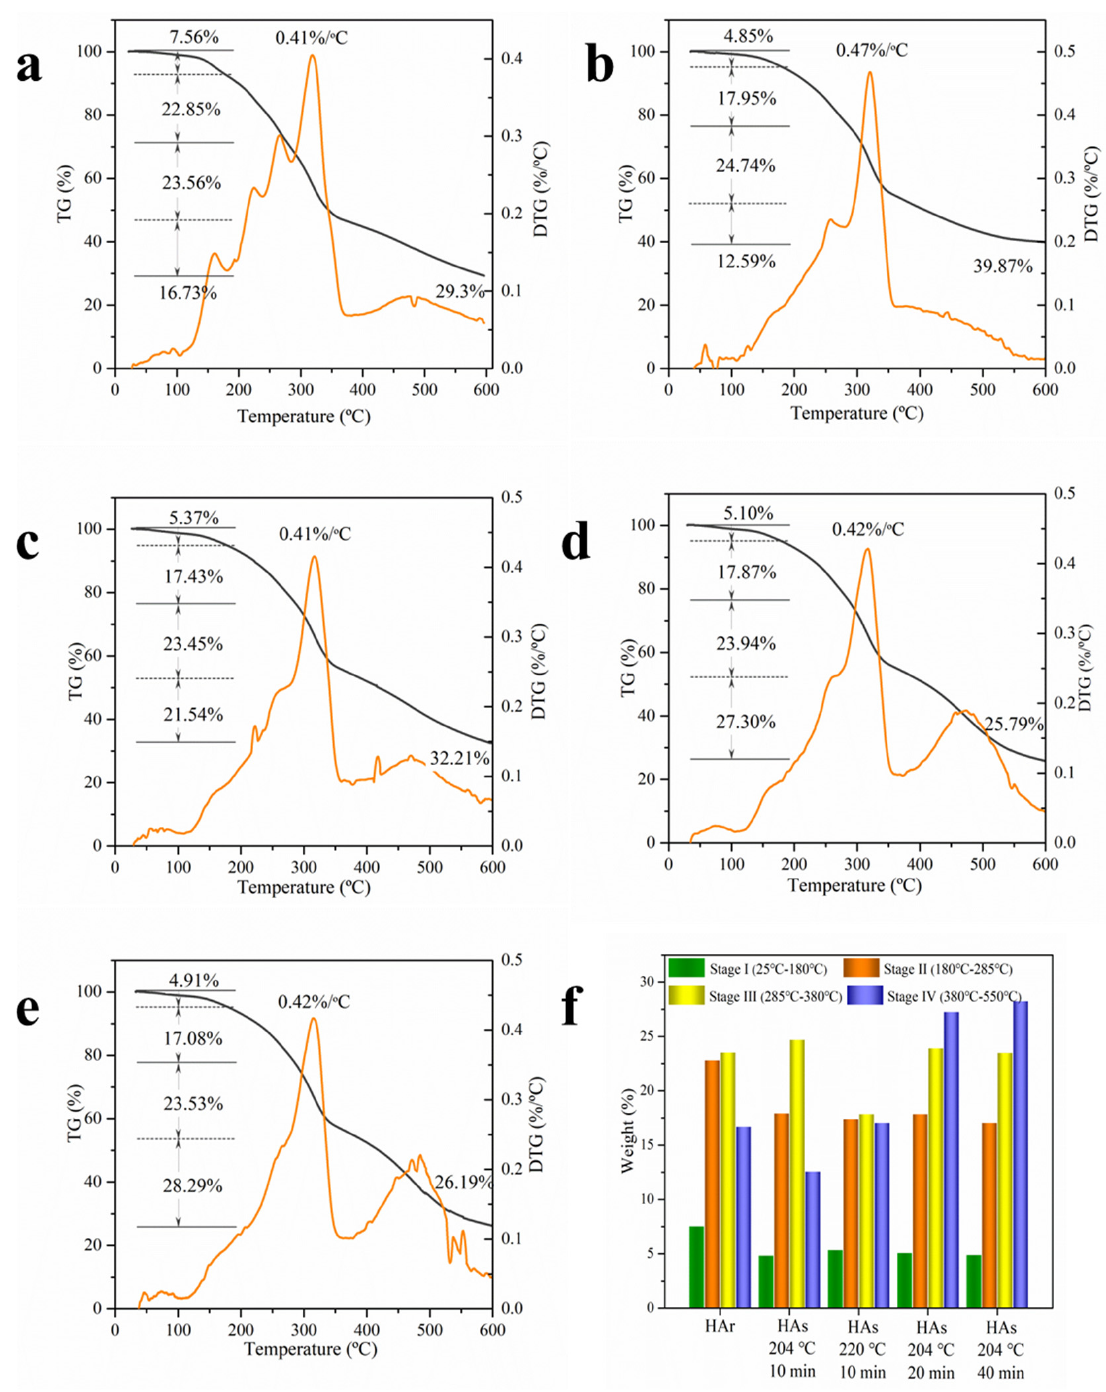
Figure 2. TG and DTG curves of raw broccoli ( a ) and SE broccoli ( b ) 184 °C 10 min; ( c ) 204 °C 10 min; ( d ) 220 °C 10 min; ( e ) 204 °C 20 min; ( f ) 220 °C 40 min.